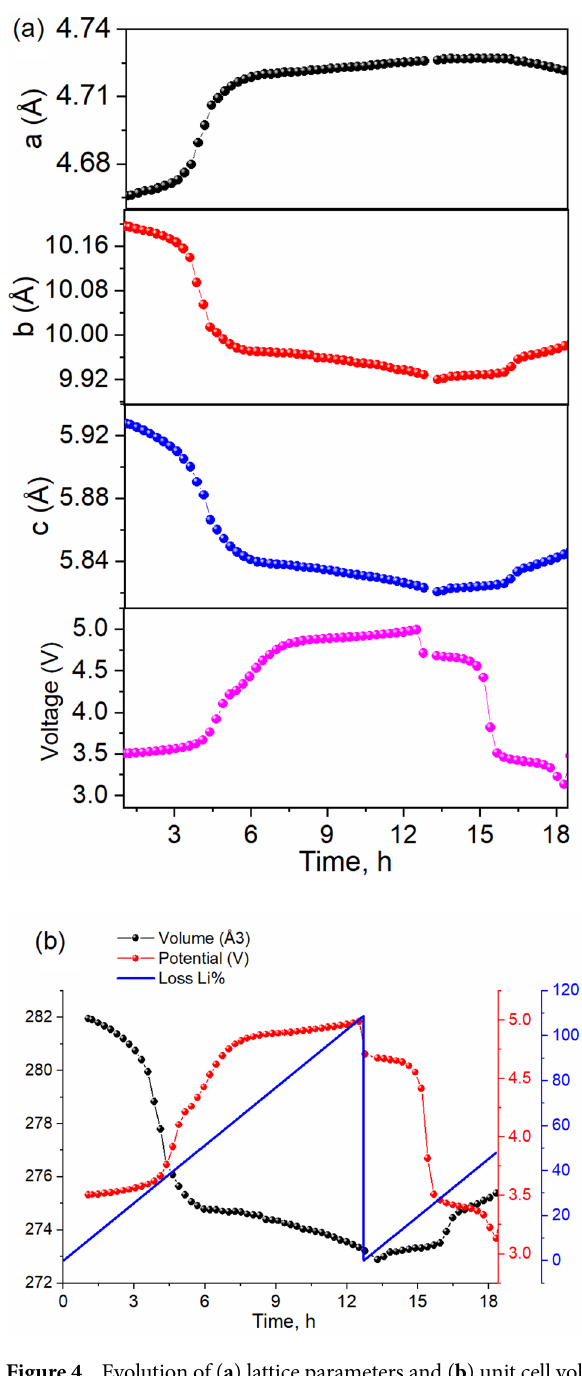
Figure 4. Evolution of ( a ) lattice parameters and ( b ) unit cell volume obtained from the operando XRD compared to the cell potential and Li loss upon the cycling of LiCo 0.5 Fe 0.5 PO 4